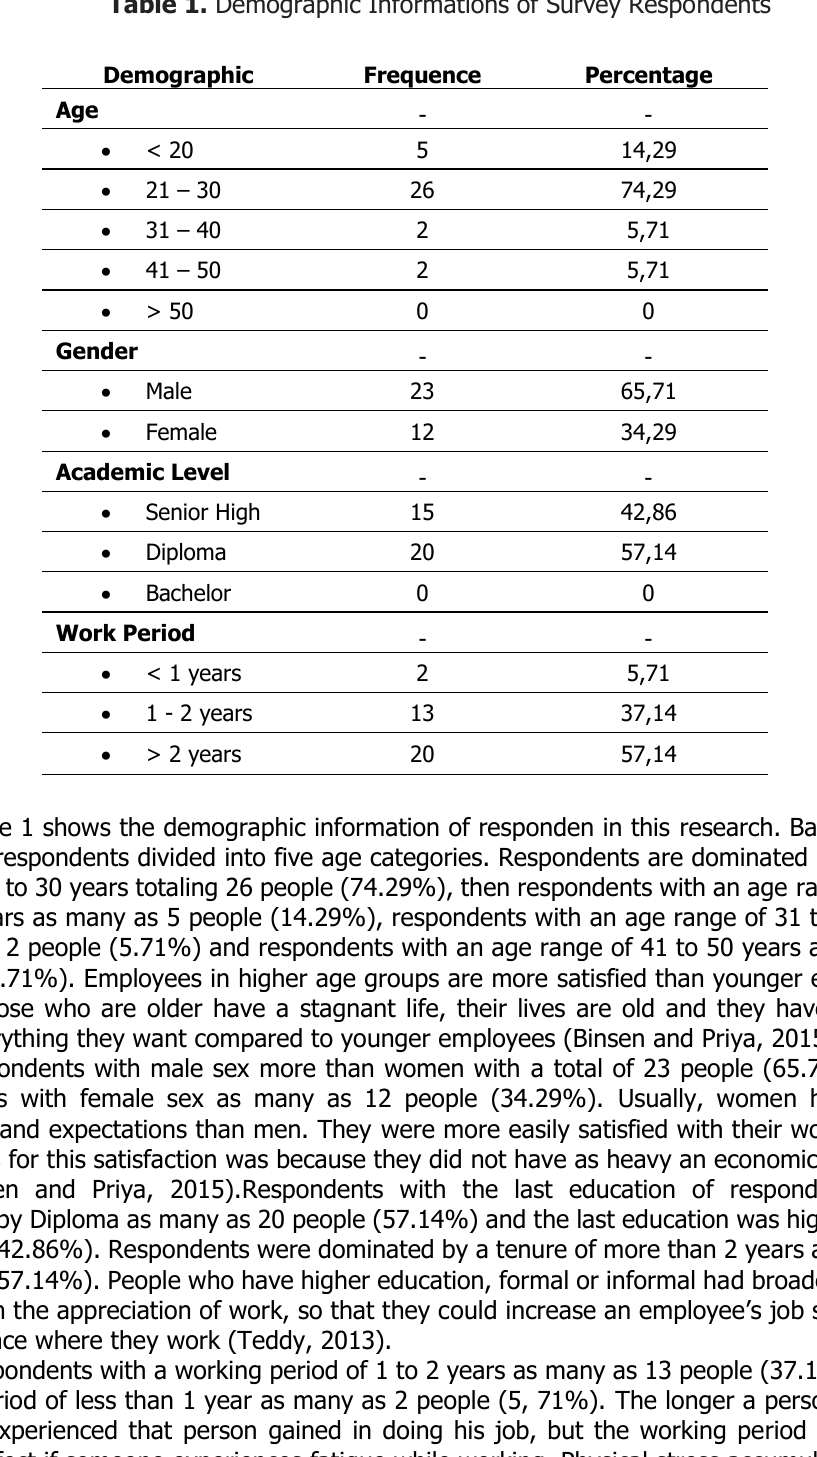
Table 1. Demographic Informations of Survey